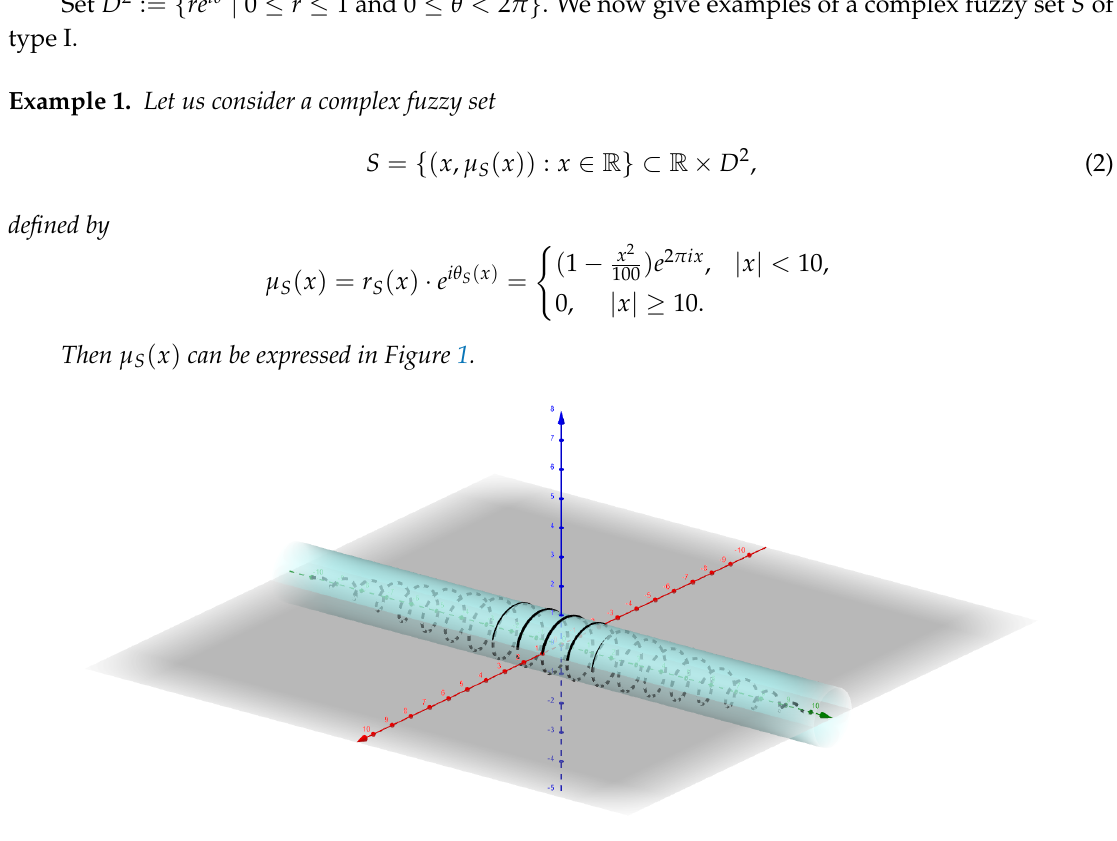
Figure 1. The complex fuzzy number of type I in Example 1